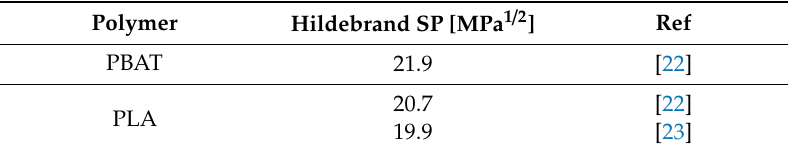
Table 3. Hildebrand solubility parameters of PBAT and PLA.